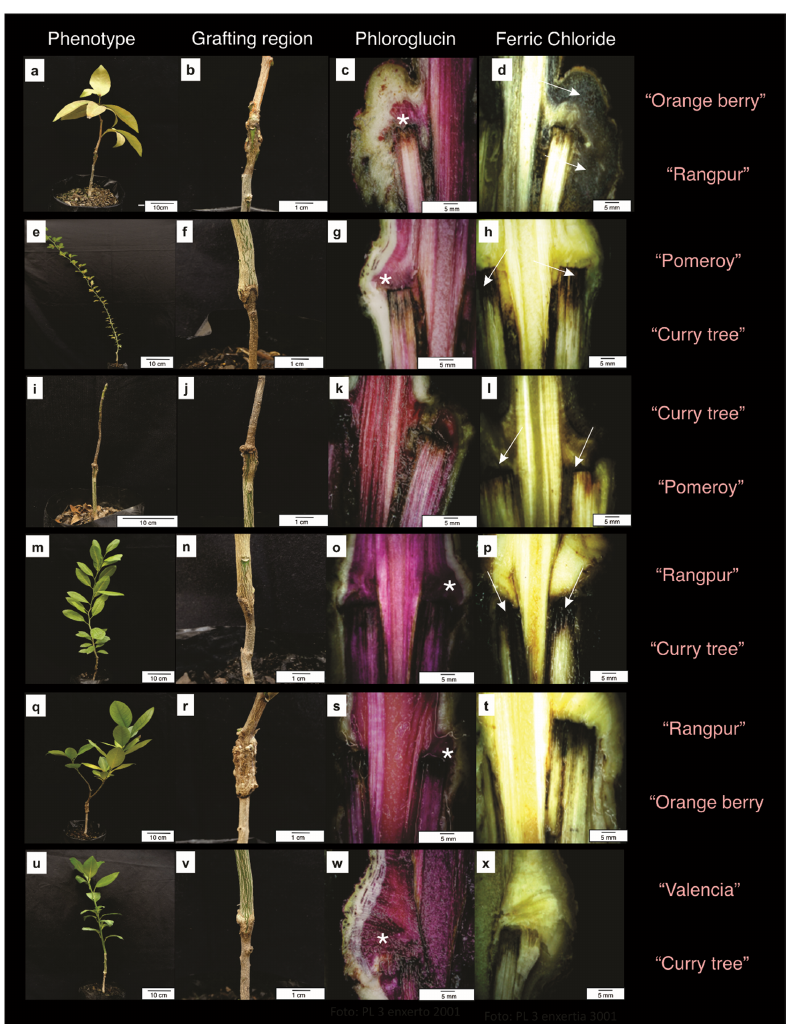
Figure 4. Six grafting combinations of Aurantioideae plants indicating the plant phenotype ( a , e , i , m , q , u ), and images of the graft union ( b , f , j , n , r , v ), phloroglucin reaction ( c , g , k , o , s , w ), and ferric chloride ( d , h , l , p , t , x ). Asterisks in ( c , g , o , s , w ): phloroglucin reaction in pink indicates lignified cell walls. Arrows in ( d , h , l , p ): ferric chloride indicates phenolic compounds in brown. Among those combinations, only Valencia/Curry tree presents some vascular connection (* in w ), whereas the oth- ers do not present a full connection (* in ( c , g , o , s )). Phenolic compounds at the grafting region were abundant in Orange berry/Rangpur ( d ), Pomeroy/Curry tree ( h ), Curry tree/Pomeroy ( l ), and Rangpur/Curry tree ( p ).